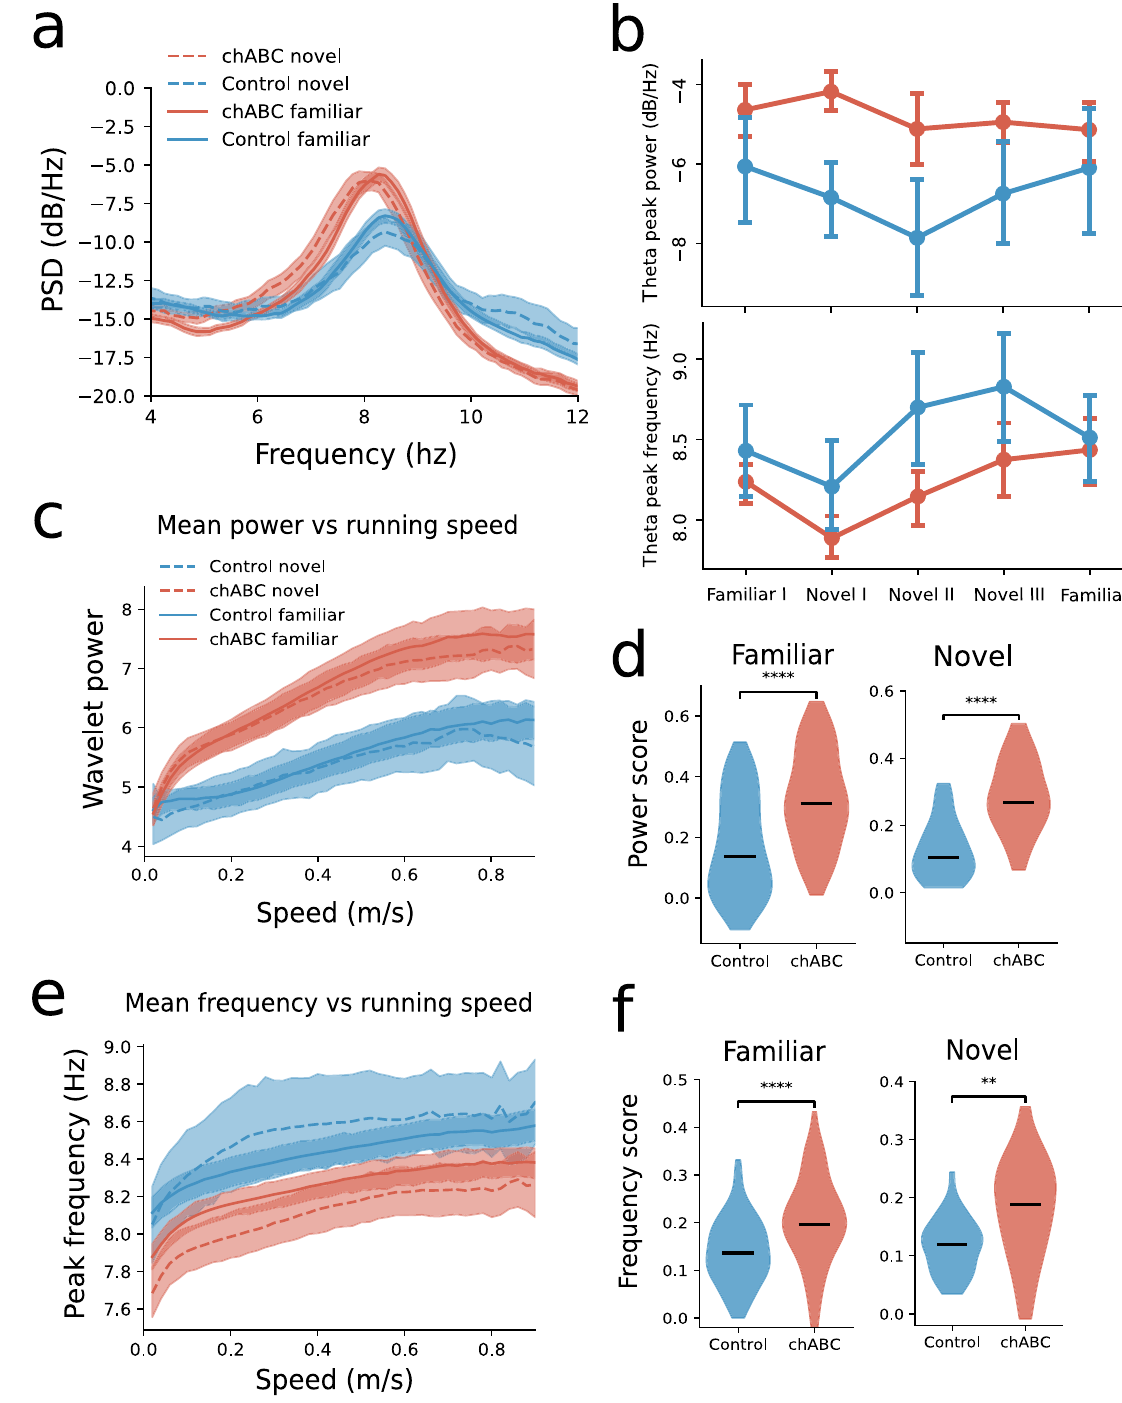
Fig. 4 Changes in theta oscillations after PNN removal. a Power spectrum of local fi eld potential in MEC shows that theta oscillations in chABC rats have increased power (dB/Hz) (median; Control familiar 6.12; chABC familiar 4.18; Control novel 7.17; chABC novel 4.8) and lower peak frequency (median; Control familiar 8.39; chABC familiar 8.27; Control novel 8.39; chABC novel 8.09) (solid line: familiar, dotted line: novel, blue: control, red: chABC). Shaded area represents 95% con fi dence interval. b Mean theta frequency for all animals during recordings in familiar and novel environments (dark colored line). Note the decrease in theta frequency during fi rst exposure to a novel environment in both groups. Dots indicate mean; error bars represent bootstrapped 95% con fi dence interval. c The mean theta power was similar when the animal was immobile, but the chABC group showed increased theta power during movement. d Power score shows increased correlation between theta power and running speed in animals treated with chABC for both familiar and novel environments (median familiar; Control 0.14 ( n = 148 recording sessions); chABC 0.31( n = 75) ( U = 2800, p <0.0001). Novel; Control 0.10 ( n = 33); chABC 0.27 ( n = 24) ( U = 102, p <0.0001)). e Theta frequency increased slightly with running speed in both groups, but the peak frequency was lower in the chABC-treated group. f Frequency score shows increased correlation between theta frequency and running speed in chABC-treated animals for both familiar and novel environment (median familiar; Control 0.14 ( n = 148); chABC 0.20 ( n = 75) ( U = 3100, p <0.0001). Novel; Control 0.12 ( n = 33); chABC 0.19 ( n = 24) ( U = 200, p = 0.002)). Number of animals: Control n = 7, chABC n = 7. Mann – Whitney U test (two sided) ** p <0.01, **** p <0.0001. Source data are provided as a Source Data fi le. NATURE COMMUNICATIONS| (2021) 12:253 |https://doi.org/10.1038/s41467-020-20241-w|www.nature.com/naturecommunications